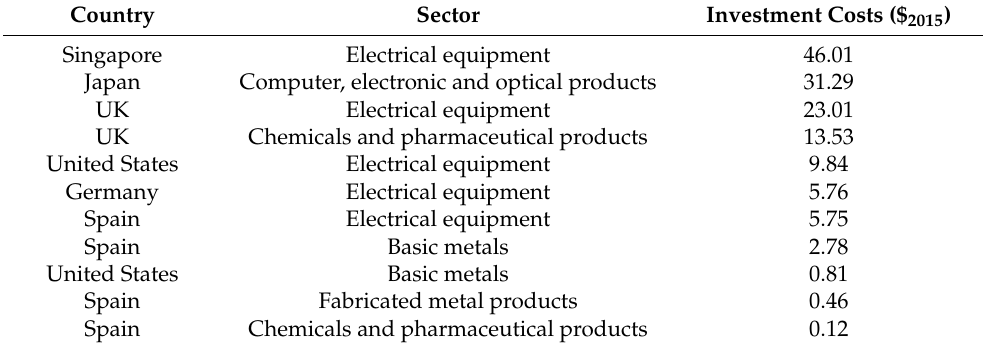
Table 4. Demand vector.